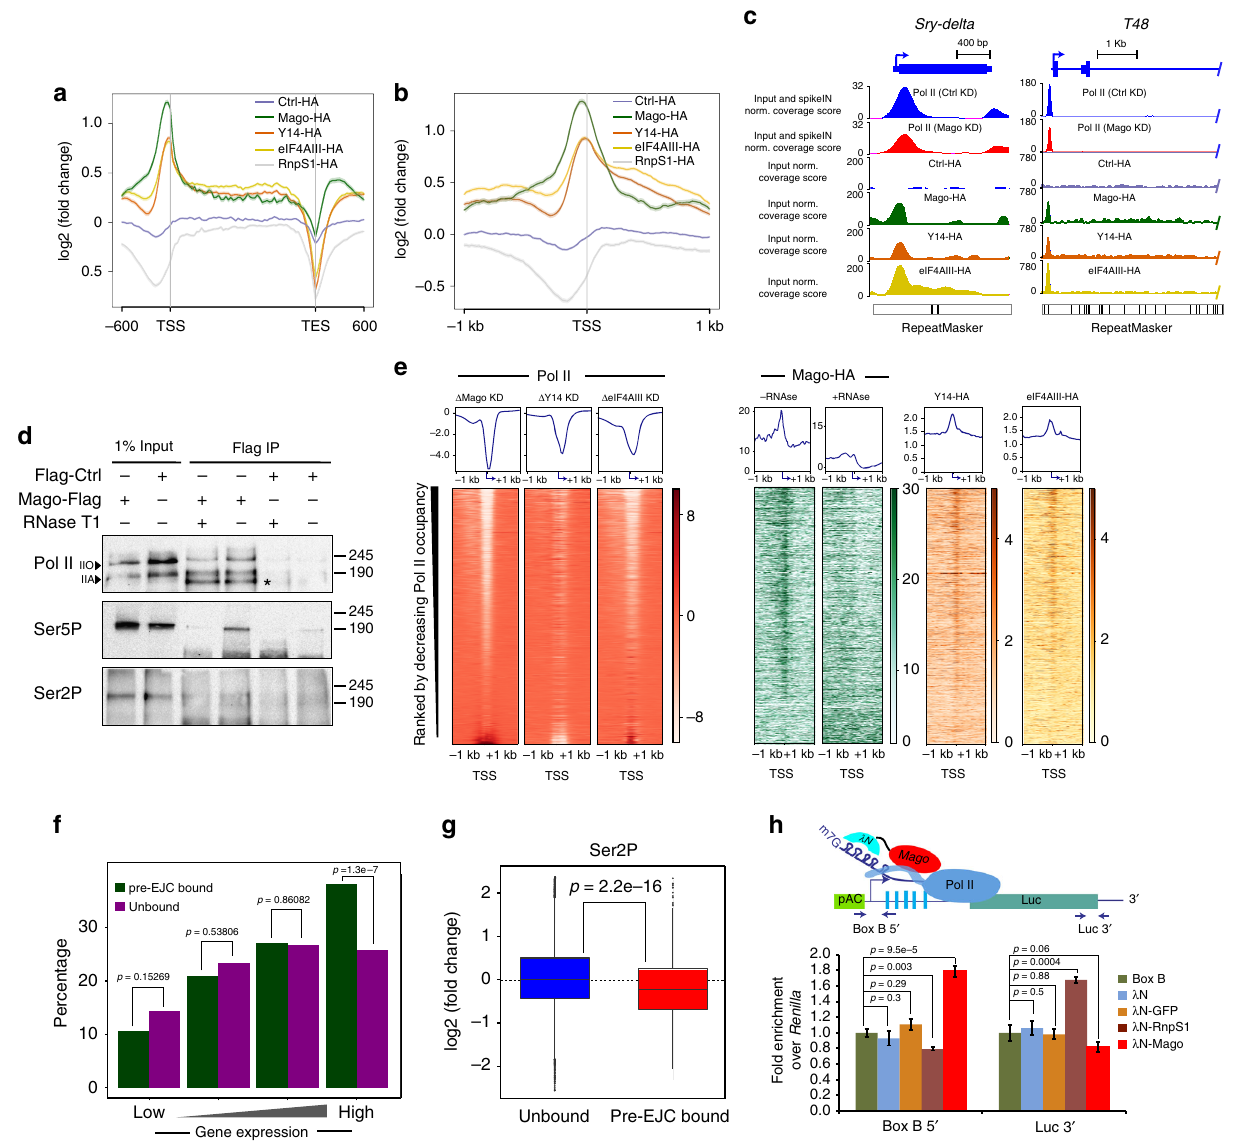
Fig. 2 Mago binding to promoter regions modulates Pol II pausing. a Metagene pro fi les of ChIP-Seq performed with HA-tagged Mago, Y14, eIF4AIII, and Ctrl, with standard error of the mean for all the expressed genes based on averaged enrichment over input for two independent biological replicates. Log2 fold changes against input control are shown on Y -axis while X -axis depicts scaled genomic coordinates. b Metagene pro fi les with standard error of mean based on average enrichment over input for two independent biological replicates of ChIP-Seq performed with HA-tagged Mago, Y14, eIF4AIII, and Ctrl, centered at the TSS in a ±1 Kb window. Log2 fold changes against input control are shown on Y -axis while X -axis depicts genomic coordinates. c Input normalized and replicate averaged track examples of ChIP-Seq experiments from S2R + cell extracts transfected with HA-tagged Mago, Y14, eIF4AIII, or Ctrl. Shown here is recruitment of pre-EJC components to an intronless ( Sry-delta ) and intron-containing ( T48 ) genes. d Co-immunoprecipitation using anti-Flag antibody from cell extracts expressing either Flag-Mago or Flag alone (Flag-Ctrl), revealed with total Pol II, Ser5P and Ser2P antibodies. Note that Mago interacts with total Pol II, both hypo (IIA) and hyper phosphorylated (IIO) forms (indicated with the arrowheads). Mago also interacts with Ser5P but not with Ser2P, and this interaction with Pol II is partially dependent on RNA. e Heatmaps of HA-tagged pre-EJC components and change in total Pol II, centered at the TSS ( − 1 kb to + 1 kb). Rows indicate all the genes bound by Pol II and are sorted by decreasing Pol II occupancy. The color labels to the right indicate the levels of enrichment. f Histogram showing percentage of pre-EJC bound genes amongst different quartiles of genes expressed in control condition. For quartile classi fi cation, all of the expressed genes in S2R + cells were divided into four equal sized quartiles according to the level of expression, from low to high level. p -values for signi fi cance of the associations, derived from Fisher ’ s exact test, are shown on top of the histogram. g Log2 fold changes in Ser2P level at the TSS upon control and Mago knockdowns, when separated according to pre-EJC binding. p -value is derived from a two- sample t -test. h Recruitment of Mago at the 5 ʹ end of RNA is suf fi cient to induce pausing. (Top) Schematic of the BoxB- λ N tethering assay. BoxB sequences (blue rectangles) were inserted upstream of the CDS of Fire fl y luciferase (green rectangle). The λ N peptide (blue) was fused to Mago (shown in red), GFP or RnpS1, and transfected into S2R + cells along with the modi fi ed Fire fl y luciferase plasmid as well as with a Renilla luciferase construct. (Bottom) Quanti fi cation of the ChIP experiment. Chromatin was prepared for the different conditions and followed by immunoprecipitation using antibody directed against total Pol II. The enrichment of Pol II at the promoter and at the 3 ʹ end of Fire fl y luciferase was calculated after normalizing against a negative loci and Renilla . The enrichment for three independent biological replicates is shown along with p -values for tested